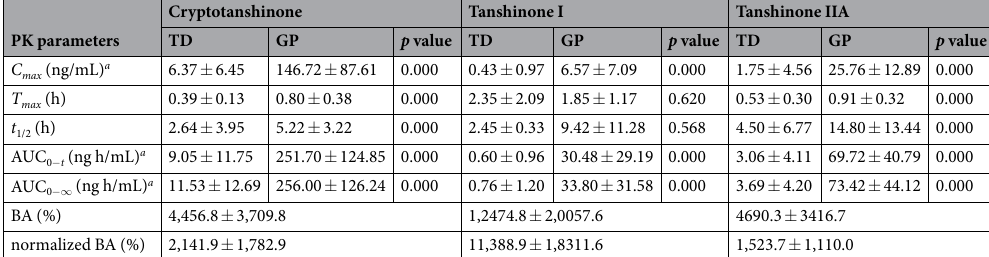
Table 2. The pharmacokinetic parameters and relative bioavailability of tanshinones in 24 subjects after administration of GP and TD of SM. Data are expressed as mean ± standard deviation, n = 24. a p values were analyzed after logarithmic transformation. SM Salvia miltiorrhiza , TD traditional decoction of Salvia miltiorrhiza , GP granular powder of Salvia miltiorrhiza, C max peak plasma concentration , T max time to reach the